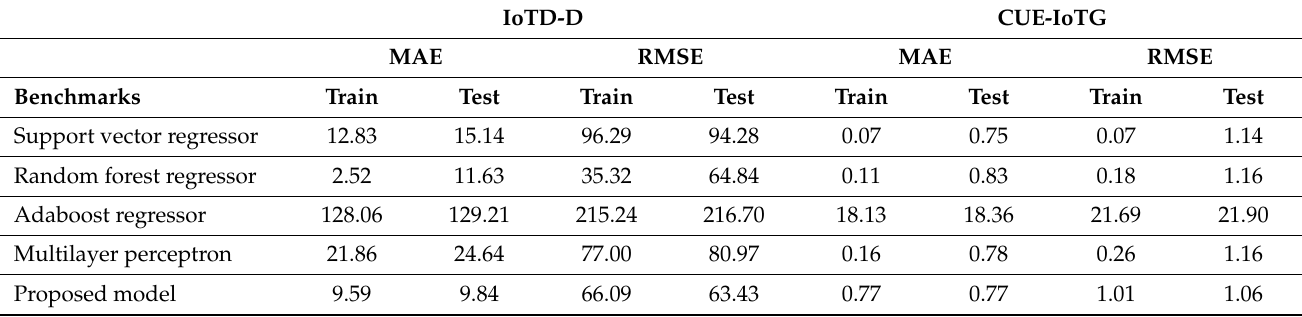
Table 6. Average result of the 10-fold cross validation method comparing the proposed uplink model versus various benchmarks including the support vector regressor, random forest regressor, Adaboost regressor, and multilayer